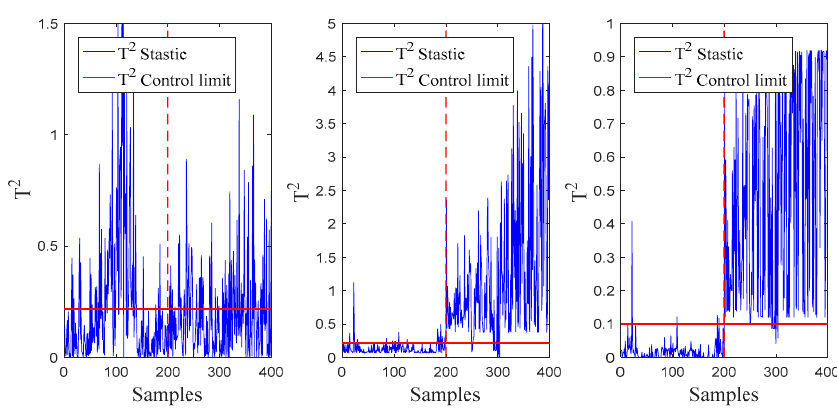
Figure 8. Monitoring results of fault 1.